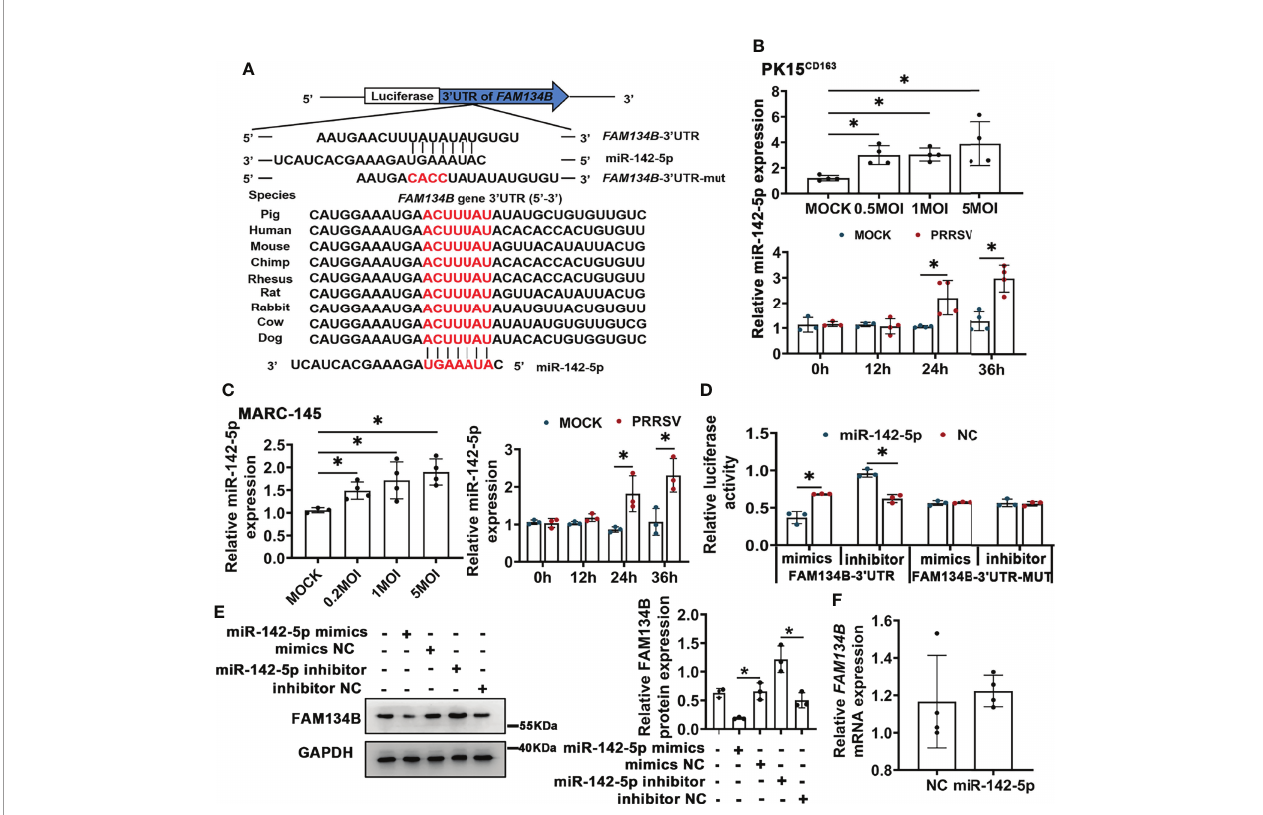
FIGURE 4 | miR-142-5p targets 3 ’ UTR of FAM134B and downregulates protein expression of FAM134B. (A) Binding site of miR-142-5p. FAM134B-3 ’ UTR-MUT vector was constructed by mutating ACUU into CACC at the binding site in FAM134B -3 ’ UTR. (B, C) Expression of miR-142-5p in PK15 CD163 cells (B) and MARC- 145 cells (C). Cells were infected with different titers of PRRSV or at different time points and were ampli fi ed by qPCR. * P <0.05, Kruskal Wallis test, n=3 or 4. (D) Luciferase activity of FAM134B -3 ’ UTR and FAM134B -3 ’ UTR-MUT from PK15 cells transfected with miR-142-5p mimic or inhibitor. * P <0.05, Kruskal Wallis test, n=3. (E) Immunoblotting assay of FAM134B in PK15 cells transfected with miR-142-5p mimics, mimics NC, miR-142-5p inhibitor, or inhibitor NC. * P <0.05, Kruskal Wallis test, n=3. (F) mRNA expression of FAM134B from PK15 cells treated with or without miR-142-5p mimic for 24 h. n=4. GAPDH served as the control in immunoblotting